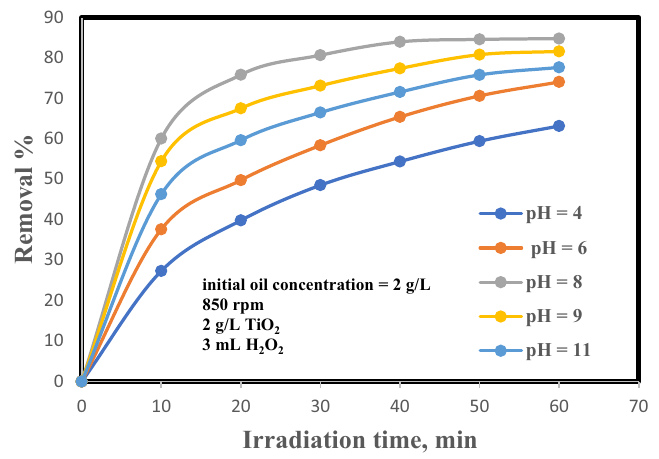
Figure 3. Influence of pH solution on the removal efficiency of oil.